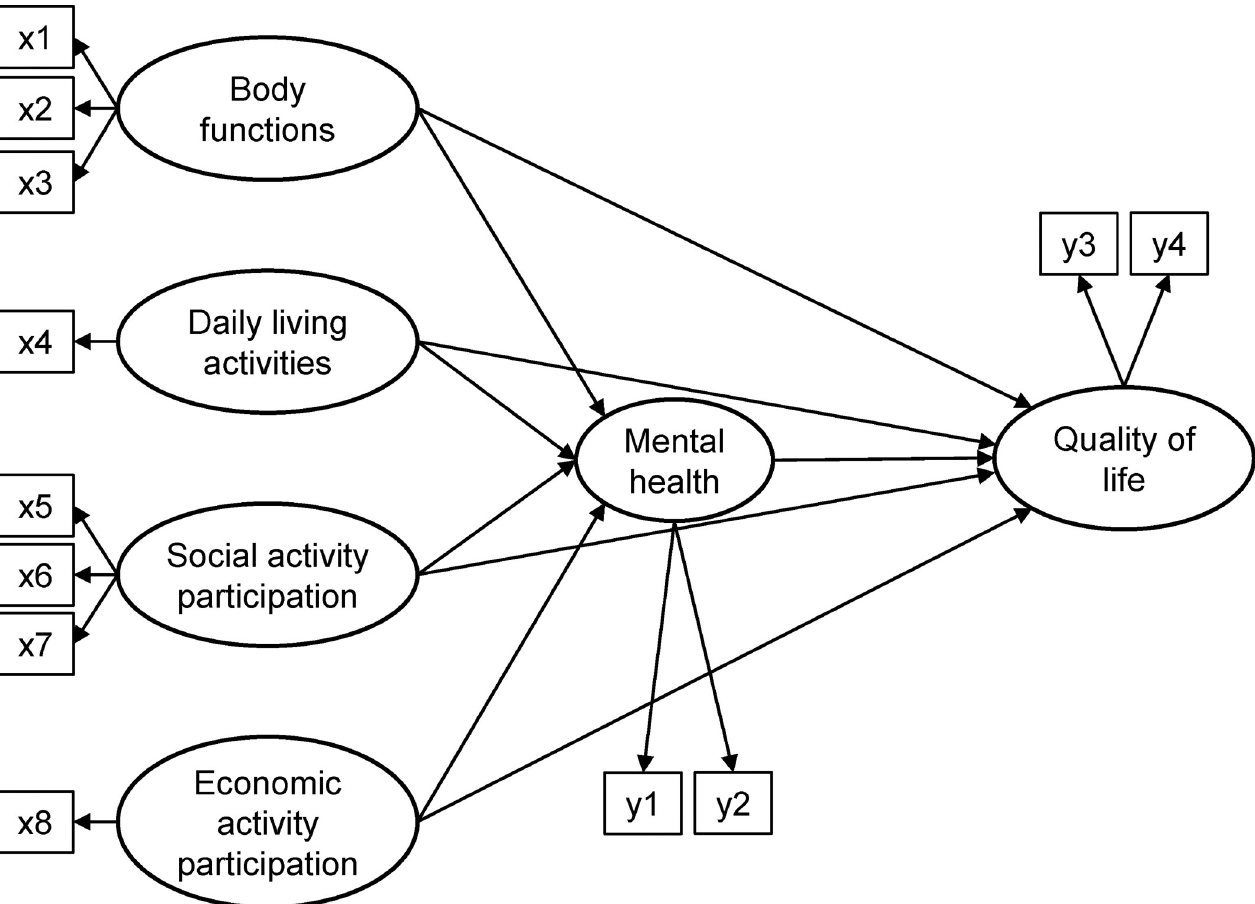
Fig 1. Hypothetical model. x1 Hand grip strength; x2 Timed up and go score; x3 Body mass index; x4 Korean instrumental activities of daily living; x5 Social activity participation frequency; x6 Number of neighbor contacts; x7 Number of family contacts; x8 Economic activity participation frequency; y1 Geriatric Depression Scale Short Form-Korean; y2 Revised UCLA Loneliness Scale-version 3; y3 Euro Quality of Life-5 Dimension index; y4 Euro Quality of Life Visual Analogue Scale.